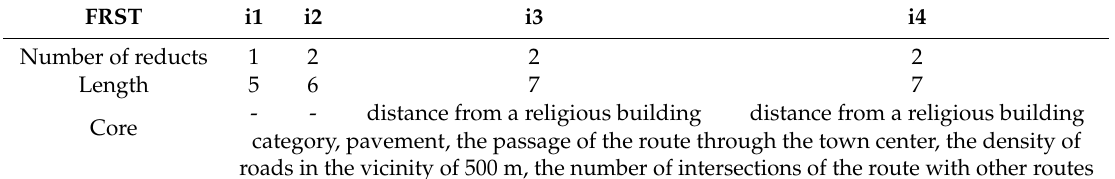
Table 7. Number, size, and cores of reducts designated using the FRST method for the selection of road sections to the scale of 1:50,000.